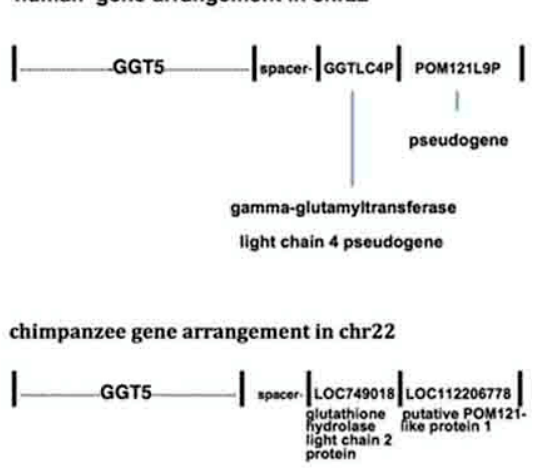
Figure 9. Nearest neighbor gene arrangements in human and chimpanzee chromosomal loci where the GGT5 gene resides.